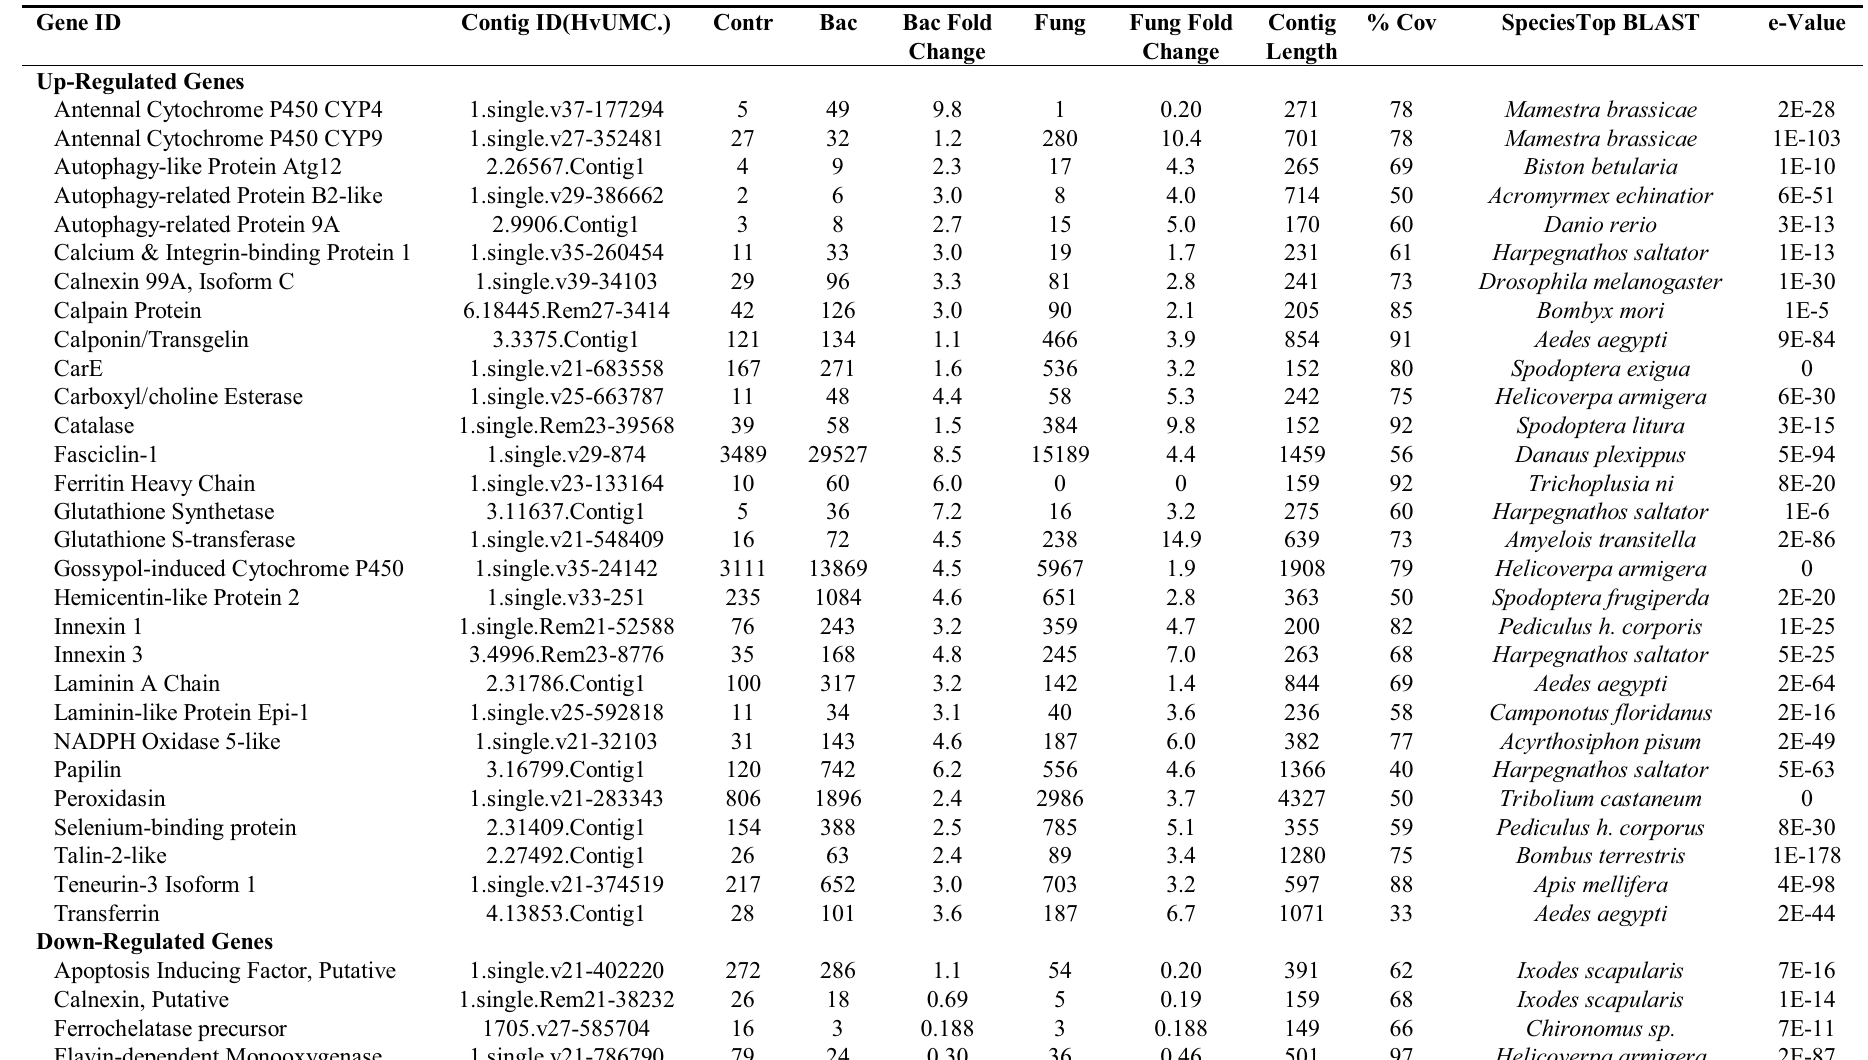
Table 4. Cellular Stress